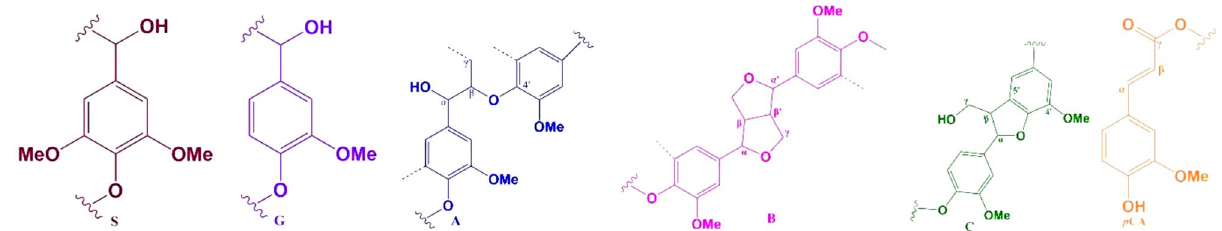
Figure 6. Main structures of organosolv lignins isolated from G. arborea and S. latifolius RCW, involving different side-chain linkages, and aromatic units identified by 2D HSQC NMR: (S) Syringyl unit, (G) guaiacyl unit, ( A ) β-O-4 ′ linkages, ( B ) resinol structures formed by β-β ′ , ( C ) phenylcoumaran structures formed by β-5 ′ , and ( p CA)